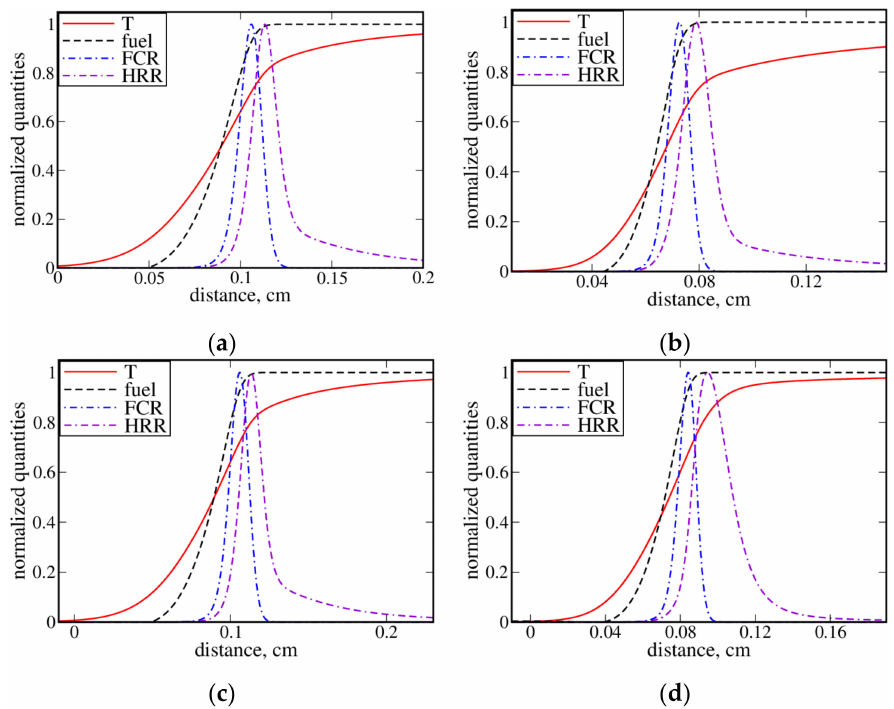
Figure 3. Profiles of c T , c F , fuel consumption rate, and heat release rate, normalized using their peak values. The profiles have been obtained from unperturbed propane–air premixed flames characterized by different equivalence ratios: ( a ) φ = 0.6, ( b ) φ = 0.8, ( c ) φ = 1.0, and ( d ) φ =